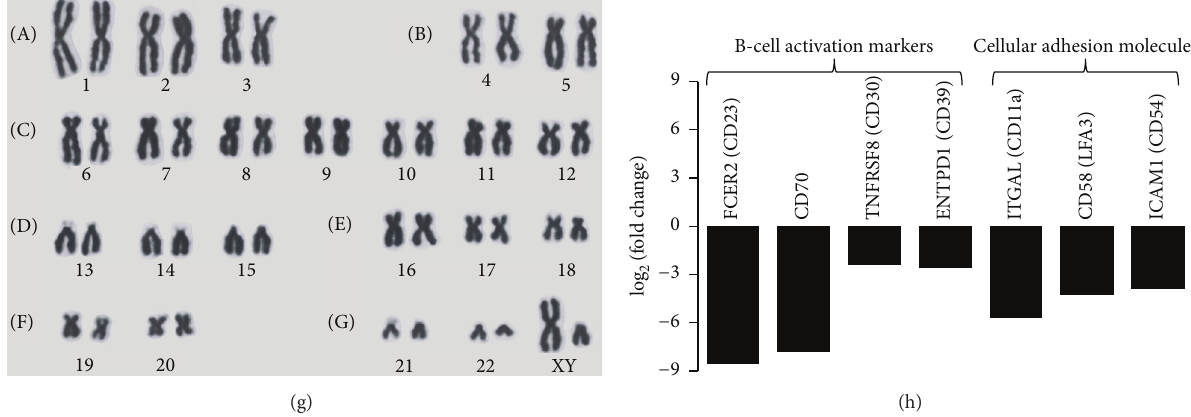
Figure 1: LCL-to-iPSC reprogramming and characterization. (a) Schematic diagram of LCL-to-iPSC reprogramming. (b) Morphology of a reprogrammed iPSC colony at 5x, 10x, and 40x original magnifications, respectively. (c) Immunocytochemistry analysis of generated iPSCs showing expression of pluripotency markers. (d) The graphs showing gene expression of core pluripotency markers in LCLs and their reprogrammed iPSCs. (e) PCR analysis of genomic DNA confirms no integration or retention of plasmid genome/transgene in the LCL reprogrammed iPSCs at passages 17–20. (f) Image showing immunocytochemistry analysis of the cells of three embryonic germ layers differentiated from reprogrammed iPSCs using monolayer differentiation protocol. (g) Image showing normal karyotype of an iPSC line. Karyotype analyses of each reprogrammed iPSC line were found to be normal. (h) The differential gene expression graph showing significant downregulation of LCL specific